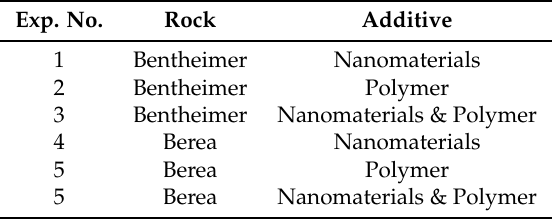
Table 6. Basic rock parameters and additives used in the experiments in earlier work [38].